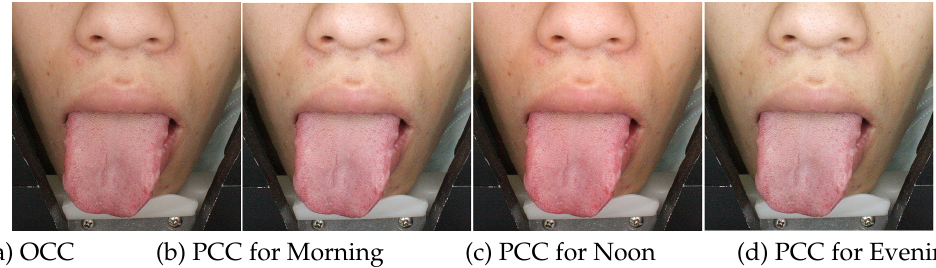
Figure 15. The PCC results with typical recommended user parameters.